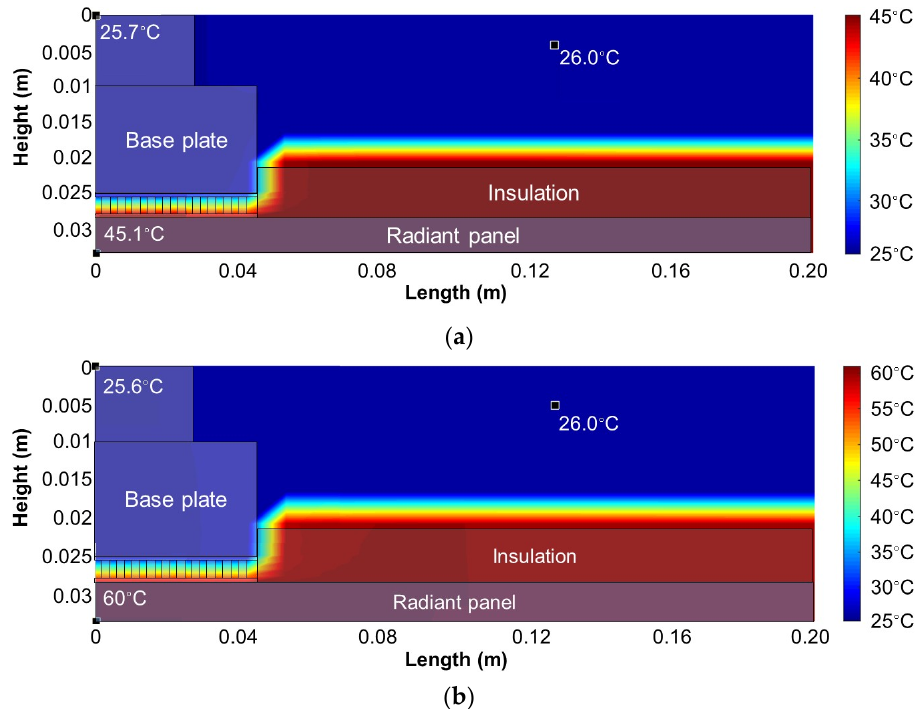
= 45 ◦ C and ( b ) T = 60 ◦ surf surf